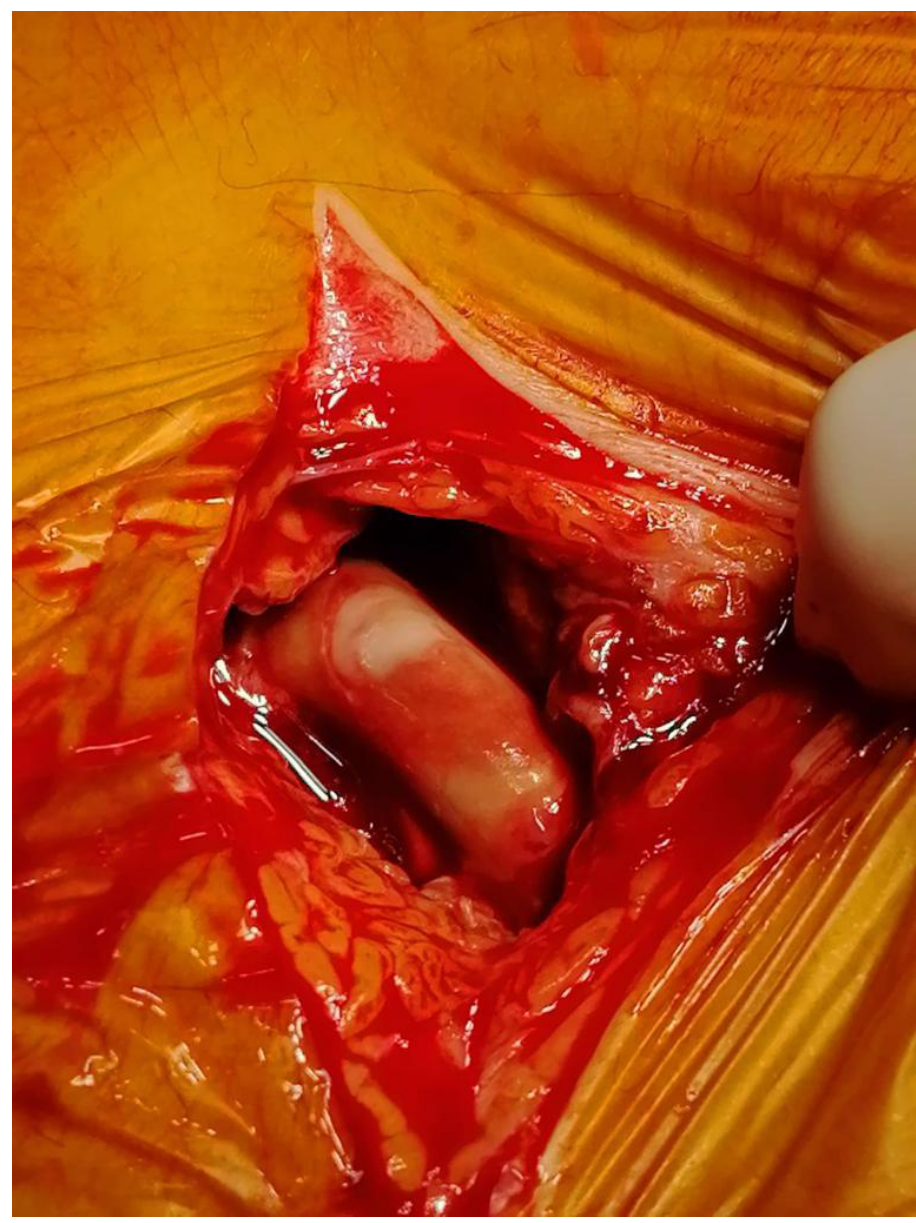
Figure 4. Explantation of an infected vascular graft at the groin.